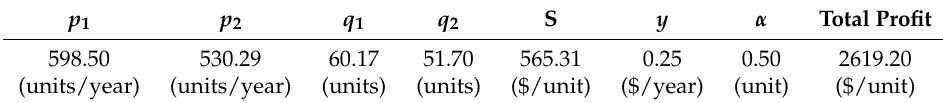
Table 3. Optimum results of Example